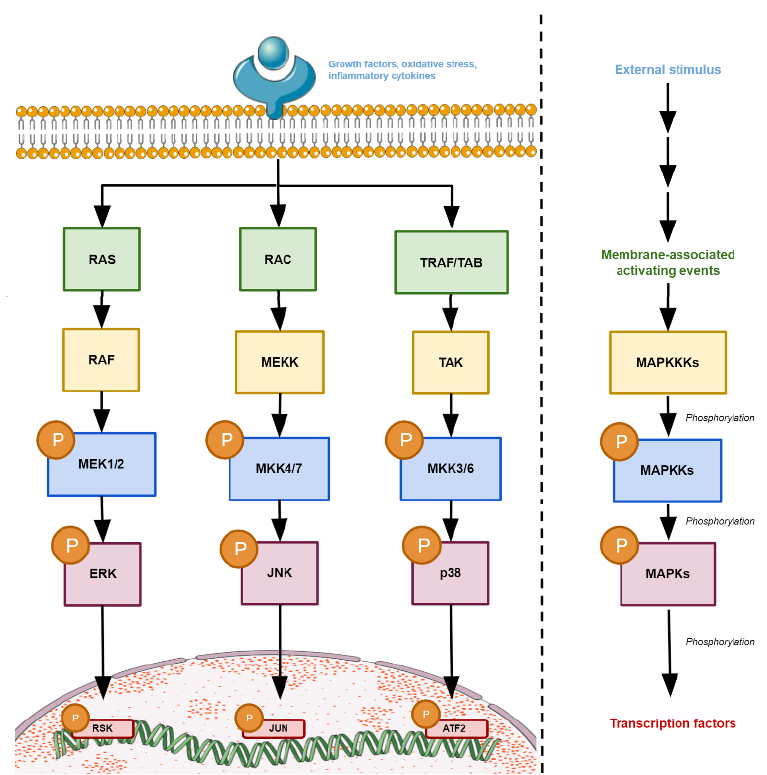
Figure 1. Scheme of the different MAPK family’s phosphorylation system. The modules shown are representative of the different connections between the components of the pathways that can occur for the respective MAPK phosphorylation systems. There are multiple components that act as external stimuli and are able to produce different events at the plasma membrane, mediated by activators belonging to the Ras/Rho GTPase family, such as RAS or RAC, or by the recruitment of adaptor proteins such as TRAF. These activate the MAPK cascade with their respective MAPKKKK, MAPKKK, and MAPKK components. Figure created using Servier Medical Art by Servier, which